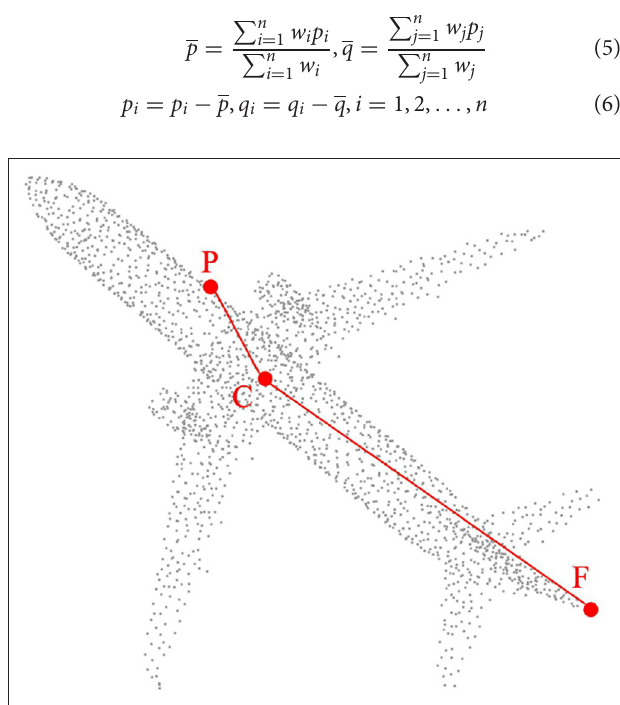
FIGURE 1 | For any point P, DeepMatch extracts a structure composed of point P itself, central point C, and the farthest point F of point P.